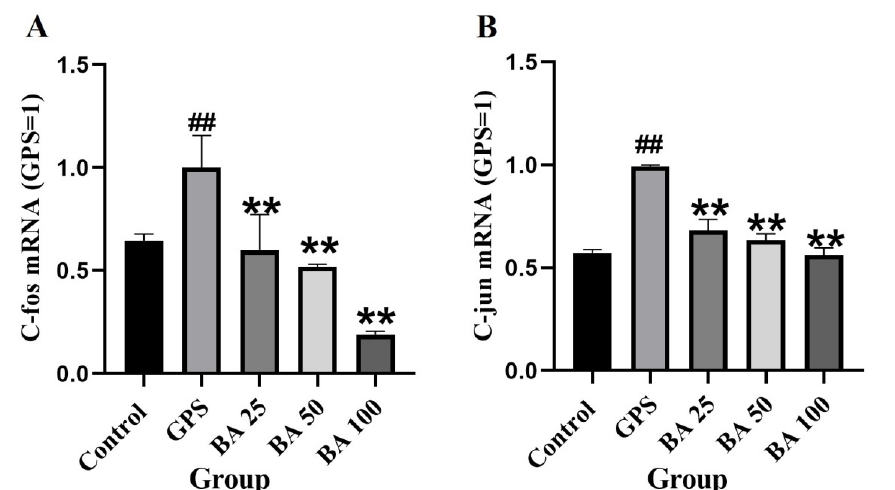
Figure 3. Inhibition effects of baicalin on PKC/MAPK signaling pathway in PMCC activated by GPS . PKC- α ( A ), ERK ( B ), p38 ( C) , JNK ( D ) (Mean ± SD, n = 3). GPS: G. parasuis group, BA 25: 25 mg/kg baicalin + G. parasuis group, BA 50: 50 mg/kg baicalin + G. parasuis group, BA 100: 100 mg/kg baicalin + G. parasuis group. ## p < 0.01 vs control. * p < 0.05 vs G. parasuis group, and ** p < 0.01 vs G. parasuis group.